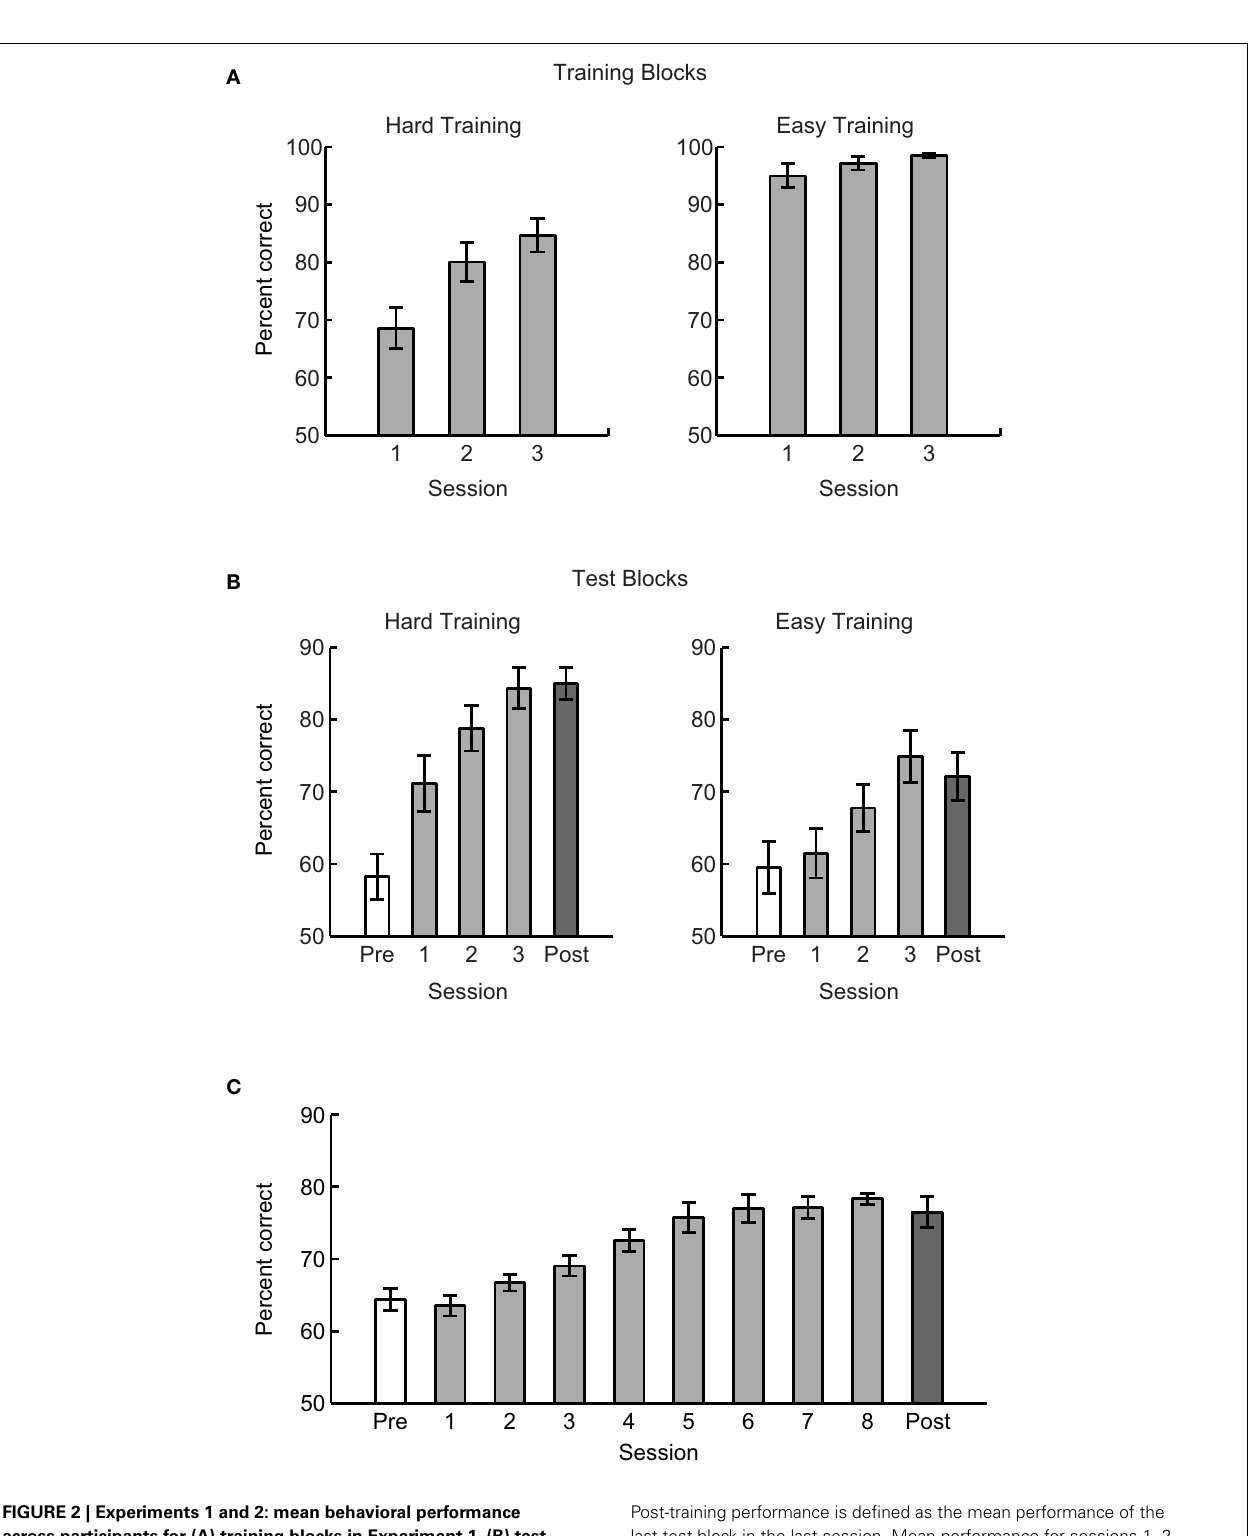
FIGURE 2 | Experiments 1 and 2: mean behavioral performance across participants for (A) training blocks in Experiment 1, (B) test blocks in Experiment 1, (C) test blocks in Experiment 2. Pre-training performance is defined as the mean performance during the first block of testing (before any training with feedback) in the first